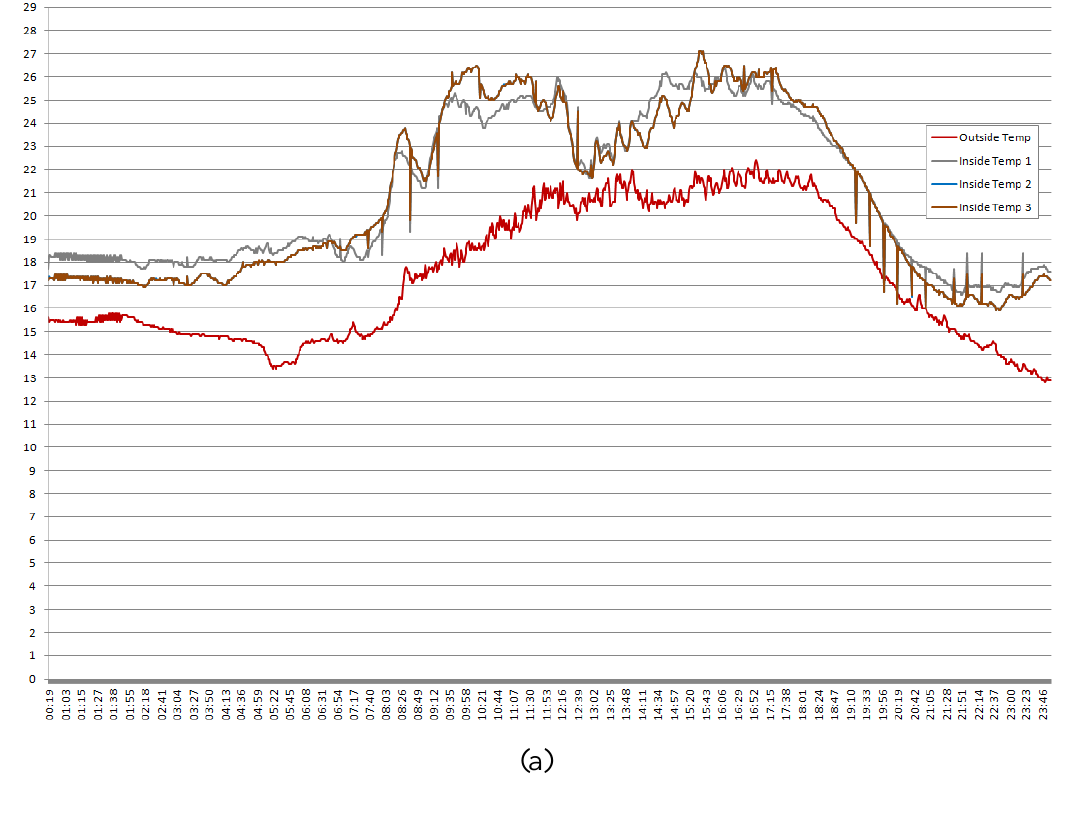
; (d) Wind Speed; (e) Solar 2